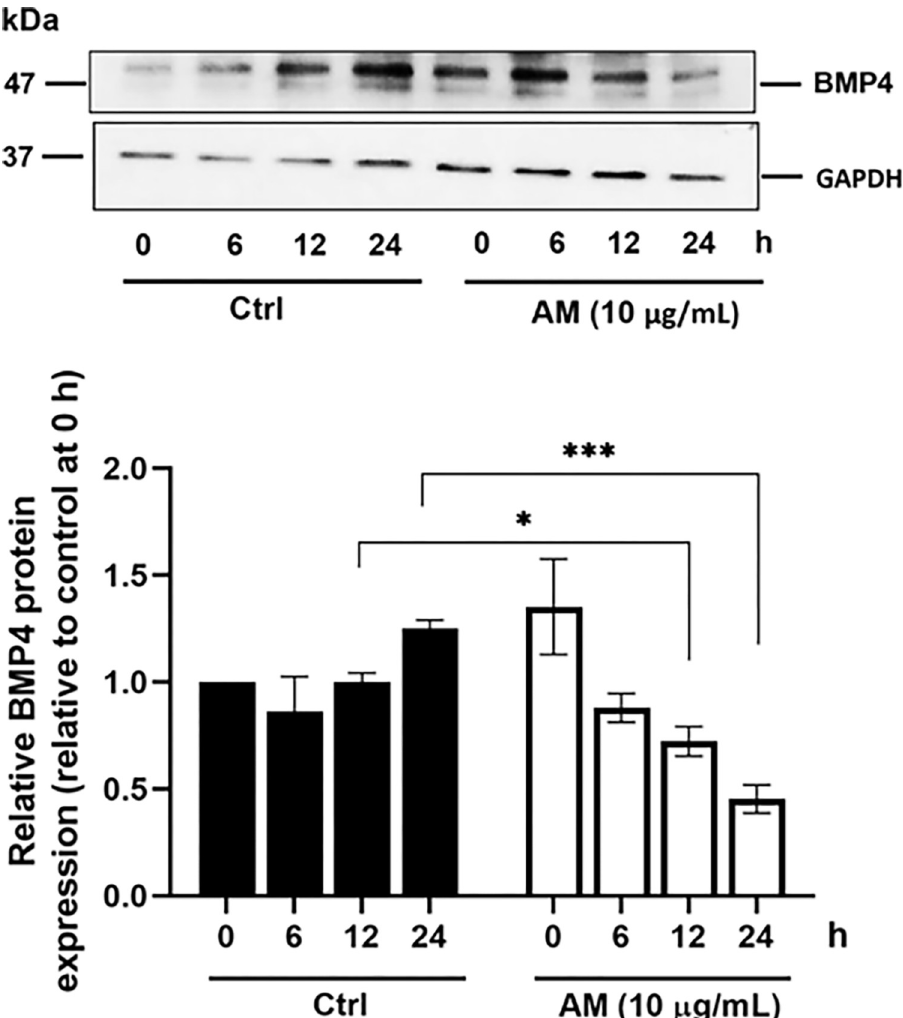
Fig 9. Effect of AM on the protein expression of BMP-4. DPCs were incubated with T (30 μ M) and were treated with the AM extract (10 μ g/mL) for 6, 12, and 24 h. DPCs were incubated only with T (30 μ M) as a control. The histograms represent the relative levels of the protein expression (relative to the control group). Quantitative analysis of the protein expression was determined by using the ImageJ software. Western blot showing the protein expression of BMP-4 in each condition, and quantitative analysis of the protein expression. The data are presented as mean ± SD (n = 3). * p < 0.05, and *** p < 0.005 versus non-treated cells.